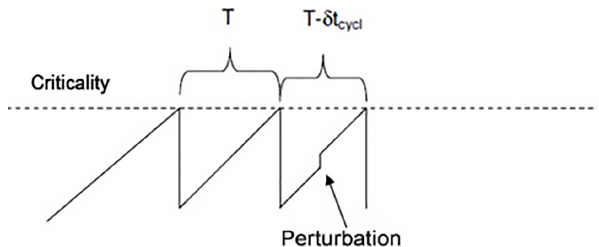
Figure 4. Representation of the shortening of the seismic cycle due to a perturbation that could be man-made. In this case the pertur- bation is of a positive nature but could be of a negative nature as well. The latter is clearly not concerning. Modified from Baisch et al.